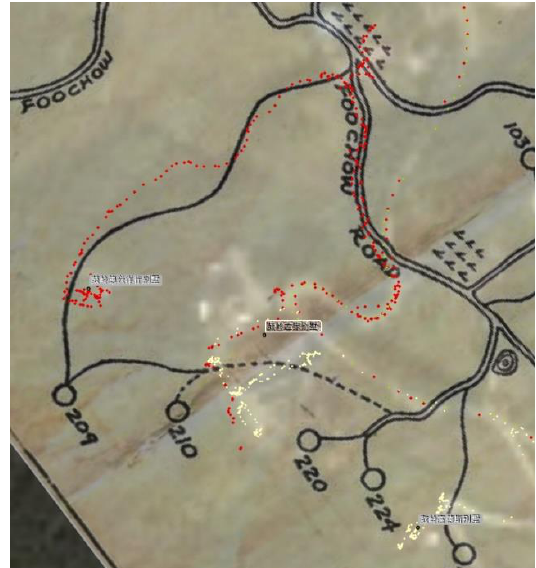
Figure 2 The 1919 Kuliang map (drawn by the missionary architect, Paul P. Wiant) was rectified roughly with the GIS system; The red and yellow dots, recorded by a Garmin handheld GPS, showed the track that the research team has walked to find the old cottages sites.